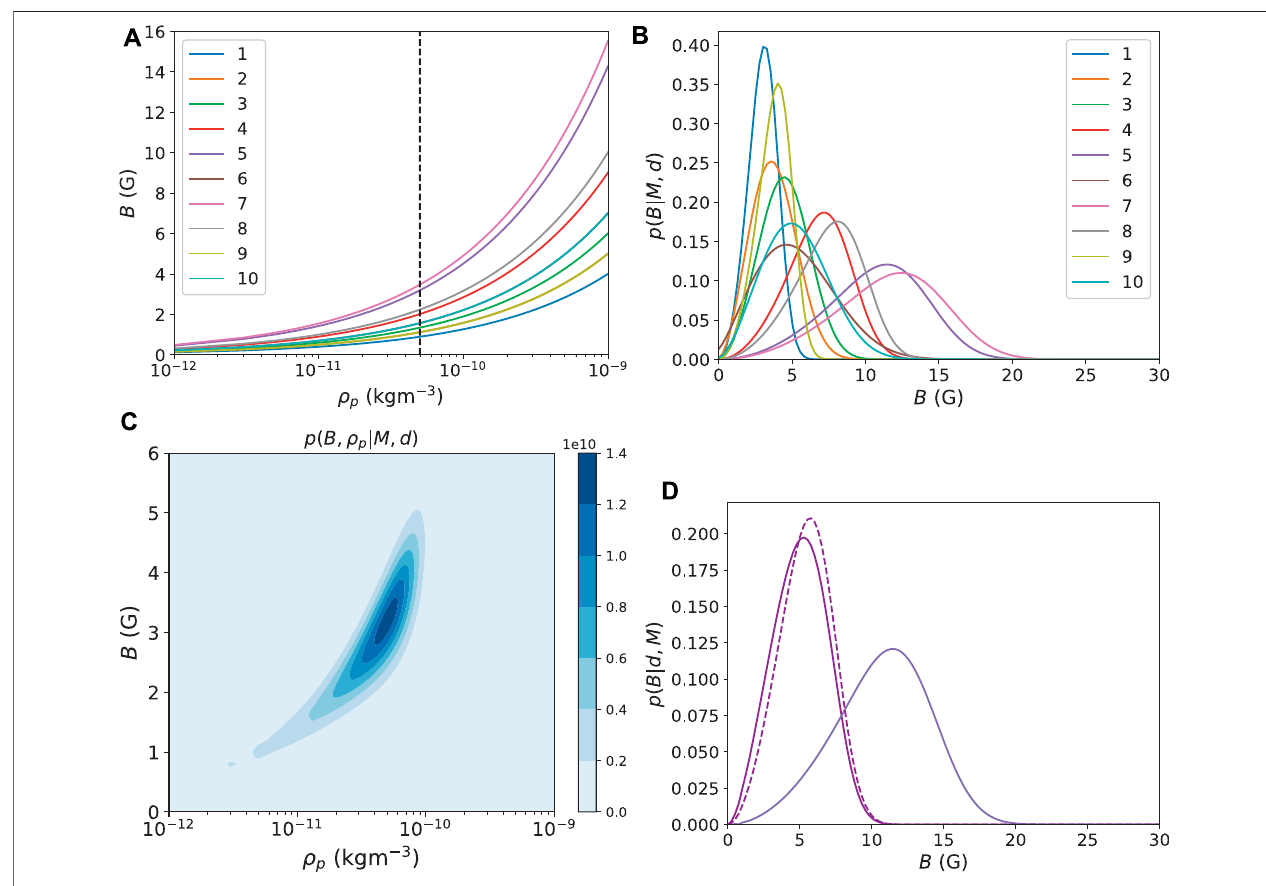
FIGURE 4 | (A) Curves obtained for each thread observed by Lin et al. (2009). (B) Posterior distributions of magnetic fi eld strength (B) for each considered thread obtainedwithBayesianmethods. (C) Globalposteriorcomputedforthe fi fththread,consideringaGaussianprioroftheinternaldensity( ρ i )centredinavalueequalto ρ p = 5×10 − 11 kg m − 3 andgivenanuncertaintyof50%. (D) Comparisonofposteriordistributionsofthemagnetic fi eldstrengthinatotally fi lledtube(purpleline),partially fi lled tube (magenta line), and partially fi lled tube considering a Gaussian prior for the proportion of thread length centred in L p / L = 0.5 with 50% of uncertainty (dashed magenta line). From Montes-Solís and Arregui (2019).